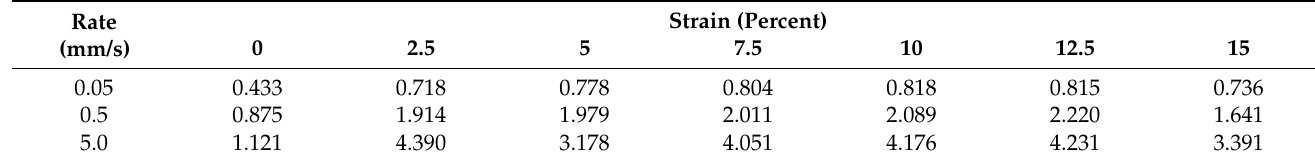
stress–relaxation constants are significantly lower, possibly due to strain-gauge